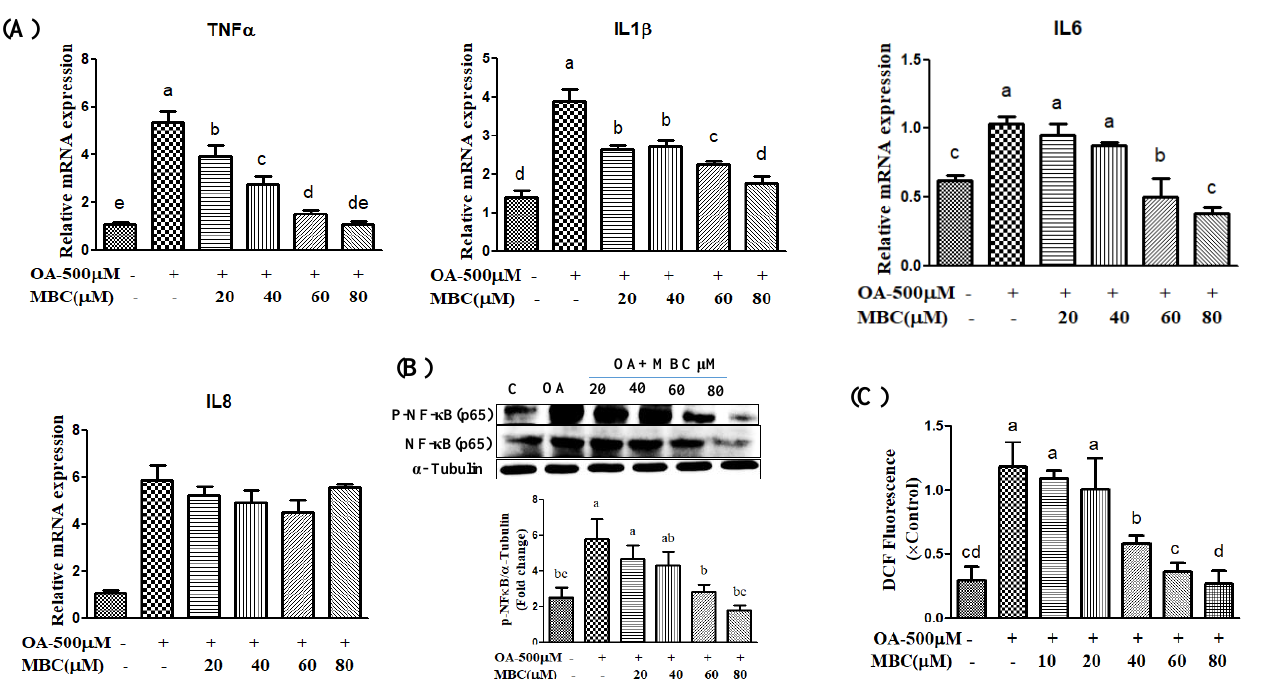
Figure 4. Effect of methyl brevifolincarboxylate (MBC) on inflammatory mediator mRNA and ROS production in OA- treated SK-HEP-1 cells. ( A ) Effect of MBC on secretion of inflammatory mediators determined by RT-PCR. ( B ) Effect of MBC on protein expression of NF-κB (p65) determined by Western blot. ( C ) Intracellular ROS level was analyzed with 2ʹ,7ʹ-dichlorodihydrofluorescein (DCF) using a fluorescence reader at an excitation wavelength of 485 nm and an emission wavelength of 535 nm. Cells were incubated with 0.5 mM of OA in the presence or absence of different concentrations of MBC for 48 h. All results were presented as mean ± SEM of three independent experiments. Data bars with similar letters were not significantly different ( p ≤ 0.05).